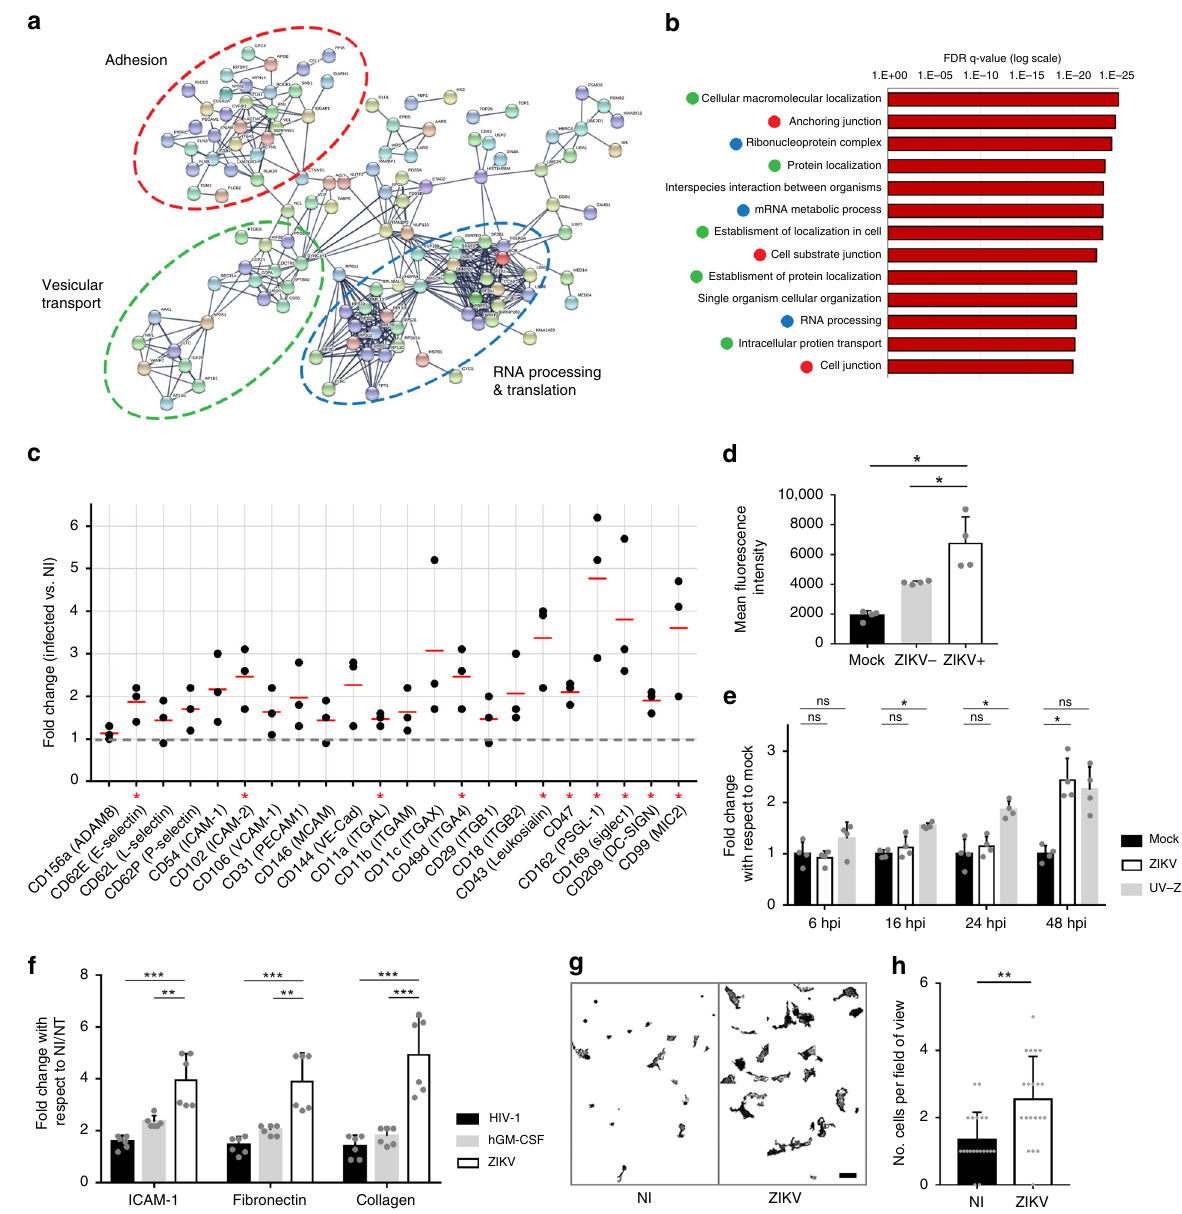
Fig. 5 ZIKV-exposed monocytes exhibit higher adhesion properties. a , b Monocytes from two donors were infected with ZIKV. At 48 hpi, the cells were processed for quantitative proteome pro fi ling by using liquid chromatography coupled to tandem mass spectrometry (LC – MS/MS). Cluster and ontology analyses of the upregulated proteins (virus over mock) were identi fi ed by using STRING ( a ) and GSEA ( b ) methods. The list of the proteins modulated upon ZIKV infection by using a 5% FDR ( p value < 0.0085) is provided in Supplementary Data 1. c Flow cytometry analysis assessing the surface expression of 22 adhesion molecules upon ZIKV infection. Each dot corresponds to the average fold change of duplicates for individual donors. The red lines correspond to the mean from three donors. The gray dashed line indicates a fold change of 1 (no differential expression between infected and noninfected monocytes). d The expression of CD99 (MIC2) was measured in monocytes from two donors treated with mock or ZIKV for 48 h. In the latter, the CD99 expression was quanti fi ed within the noninfected (ZIKV – ) and the infected (ZIKV + ) populations. e Expression of CD99 was measured over time on monocytes from two donors treated with mock, ZIKV, and UV-inactivated ZIKV. The bar graphs show the fold change of CD99 expression with respect to mock (mean ± SD). f Noninfected/nontreated (NI/NT), hGM-CSF-treated, ZIKV-, or HIV-infected monocytes were plated in wells coated with collagen, ICAM-1 protein, or fi bronectin. The relative number of cells was measured by using CellTiter-Glo. Each bar graph corresponds to an experiment performed on monocytes from two healthy donors showing the mean ± SD from two individual experiments. g , h ZIKV-infected or NI monocytes of two donors were cocultured with hCMEC/D3 cells grown on glass coverslips. Upon fi xation and staining with an anti-CD45 antibody, the number of adherent monocytes was quanti fi ed by confocal microscopy ( g and Supplementary Fig. 9a, b). Scale bar: 20 µ m. h The bar graph corresponds to the mean ± SD of the number of monocytes counted per ten fi elds of view from two individual experiments for two donors. Two-tailed p value was nonsigni fi cant (ns), <0.05 (*), <0.005 (**), or <0.0005 (***). Statistical signi fi cance was determined by using a t test. NI noninfected, NT no cytokine treatment. Source data in b – f , h are provided as a Source Data fi le